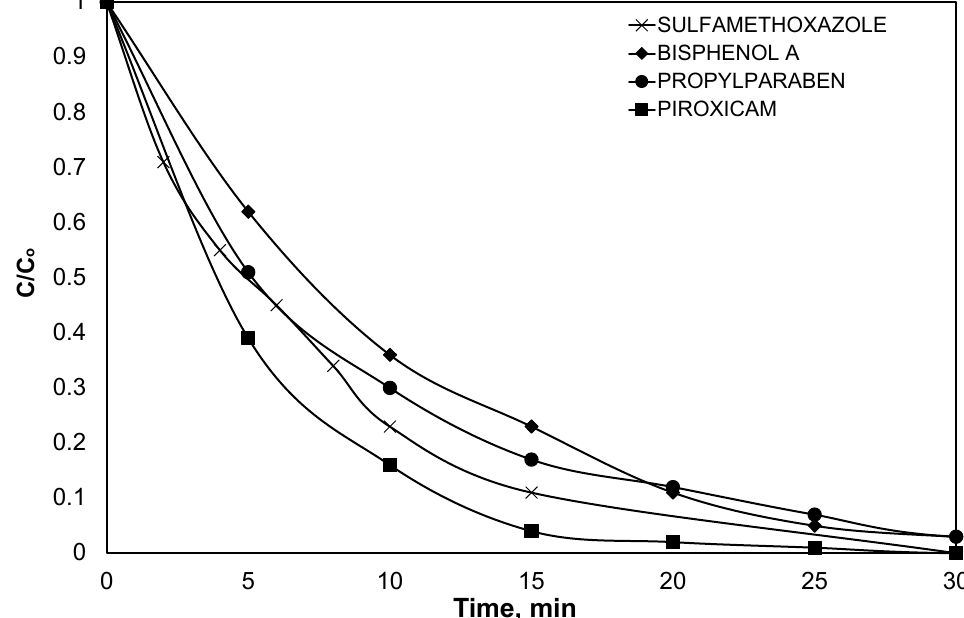
Figure 8. Degradation of different micropollutants using the hybrid 3D process. Conditions: [SMX]° = [BPA]° = [PIR]° = [PP]° = 500 μ g/L, [BCS_650] = 2 g/L, [Na 2 SO 4 ] = 0.1 M, j = 8 mA/cm 2 , ultrapure water.